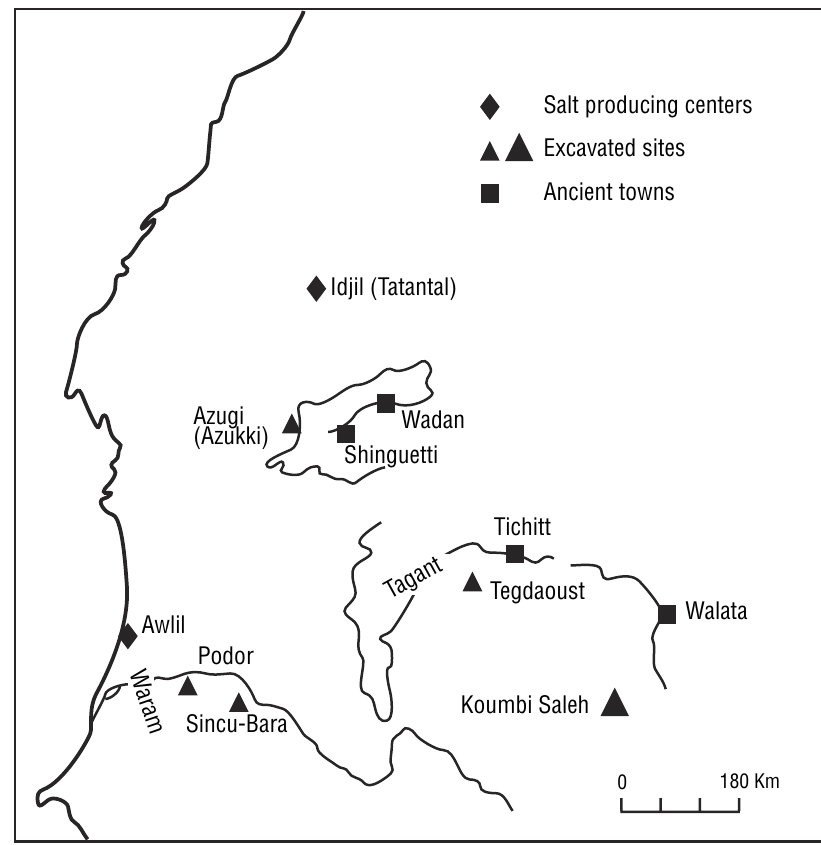
Figure 3 – Western Sahara, Senegal Valley, and Western Sahil